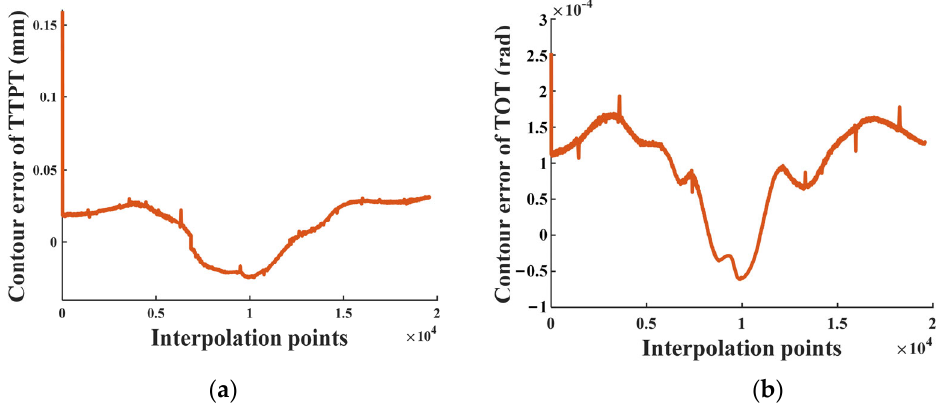
Figure 19. The predicted contour errors. ( a ) The TTPT contour error; ( b ) The TOT contour error. In order to verify the correctness of the predicted contour error, the CS100 CMM is employed to measure a trajectory of the ruled surface A. A total of 900 points are measured on the Measured Trajectory (MT) is shown with a black line in Figure 20. The ST and AT in this section are also shown in this figure with blue and red lines for comparison. The accuracy of the CMM is 1.5 µ m + L ( mm ) /350, where L is the measurement length.